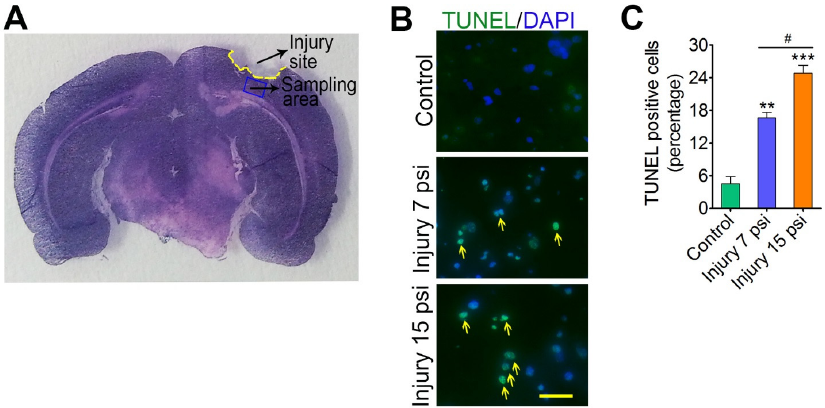
Figure 2. TUNEL staining (green) shows the apoptotic cells. ( A ) Hematoxylin and Eosin staining shows the FPI area (yellow mark) and the region evaluated (blue rectangular mark) in the coronary section of rat brain cortex; ( B ) TUNEL staining (green) shows the apoptotic cells in the mice subjected to control, 7 psi injury and 15 psi. Yellow arrows indicate TUNEL positive cells. Nucleus was counter ‐ stained with DAPI (blue). Scale bar: 50 μ m; ( C ) Percentage of TUNEL positive cells in mice brain slices 9 days after injury. Values are mean ± SEM; n = 4. ** p < 0.01, *** p < 0.001 versus uninjured control; # p < 0.05 versus 7 psi injury.